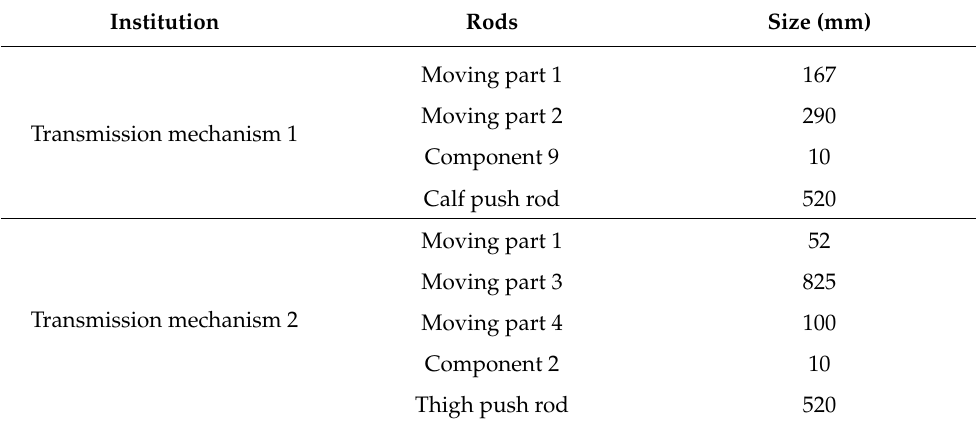
Table 3. Dimensions of the transmission